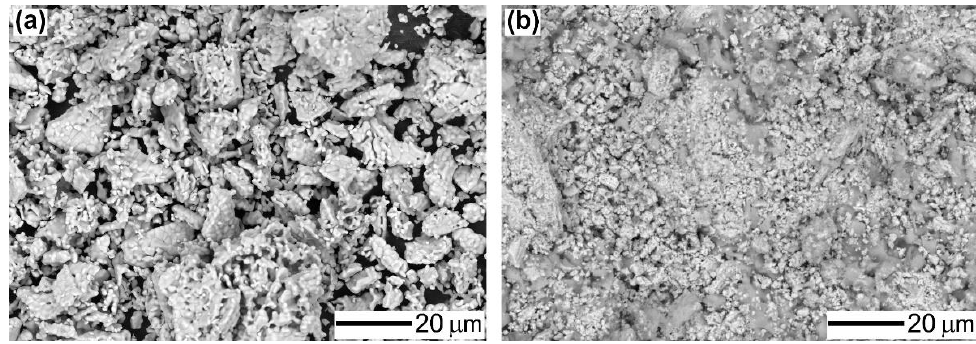
Figure 2. SEM images of S 2 Ce powder ( a ) and S 2 Ce cement (W/P = 0.4) at 28 d after mixing ( b ).